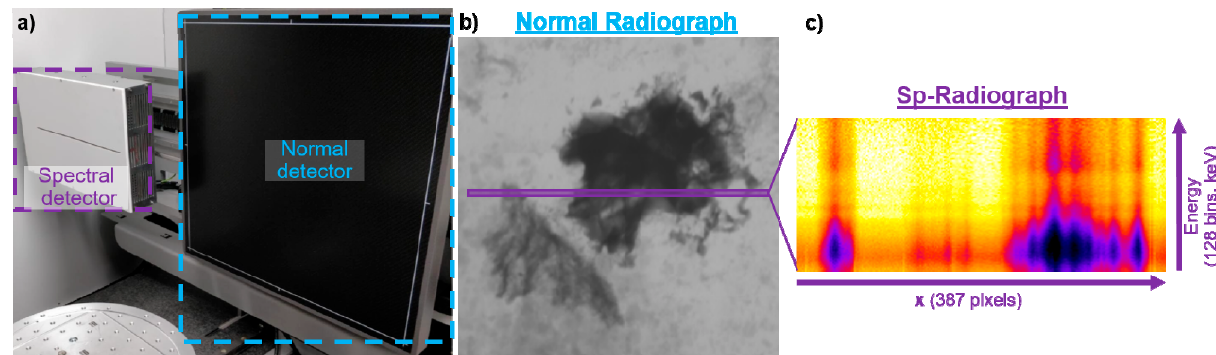
Figure 2. Schematics of the experimental setup ( a ), with an example of a typical normal radiograph ( b ) and an sp-radiograph ( c ). Note that the spectral detector can be moved in and out of the front of the normal detector and is aligned to measure precisely at the centreline.